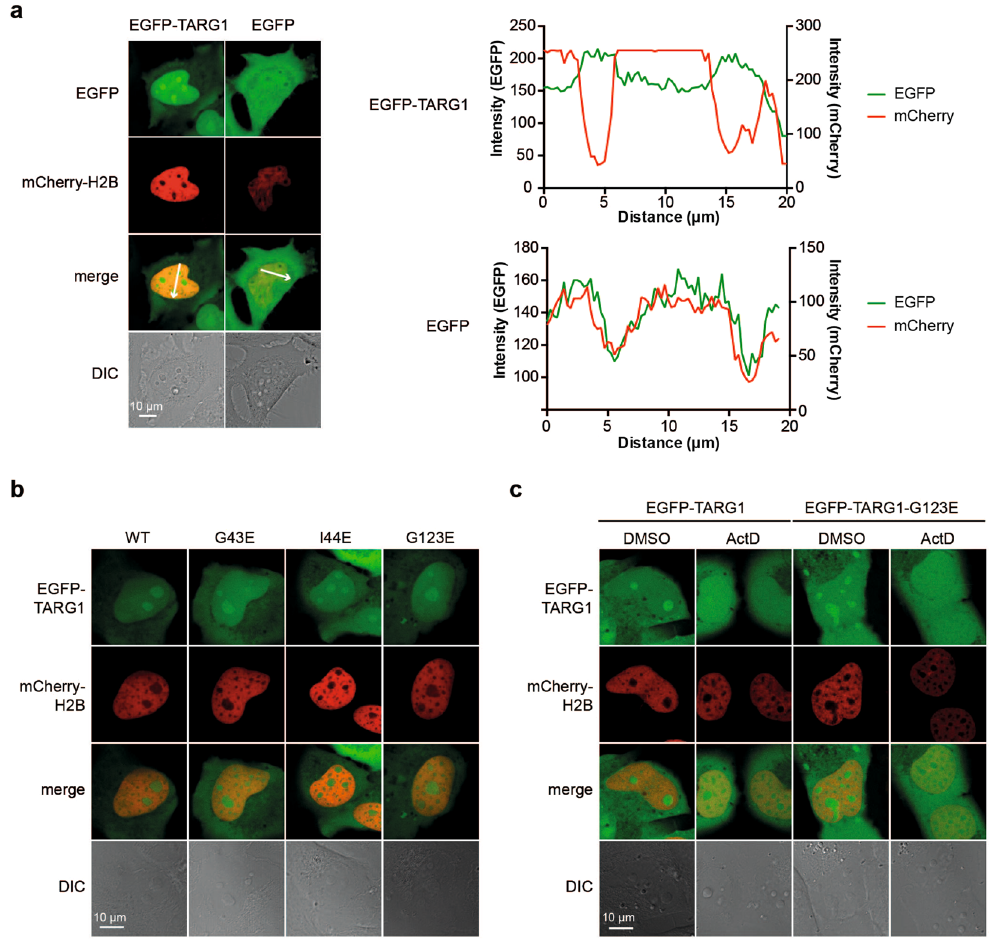
Figure 3. EGFP-TARG1 localizes to transcriptionally active nucleoli independent of ADP-ribosylation. ( a ) Live cell imaging of U2OS cells transiently expressing EGFP-TARG1 or EGFP together with mCherry-H2B. Intensity profiles for EGFP and mCherry fluorescence signals are displayed that were measured along the arrows depicted in the merge pictures. DIC: differential interference contrast. ( b ) Live cell imaging of U2OS cells transiently expressing EGFP-TARG1 wildtype (WT), G43E, I44E or G123E together with mCherry-H2B. For intensity profiles, see Supplementary Figures S7. ( c ) U2OS cells transiently expressing EGFP-TARG1 or EGFP-TARG1- G123E together with mCherry-H2B were treated with 10 ng/ml actinomycin D (ActD) or DMSO for 90 min. Subcellular localization of EGFP-TARG1 (wildtype or G123E) was analyzed by confocal microscopy in living